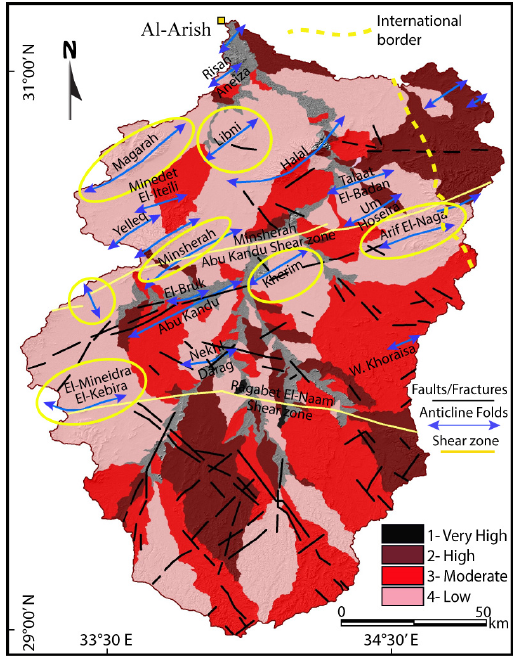
Figure 9. Distribution of the RTAL index of relative tectonics in the Wadi Al-Arish. Yellow polygons show the RTAL anomalies.